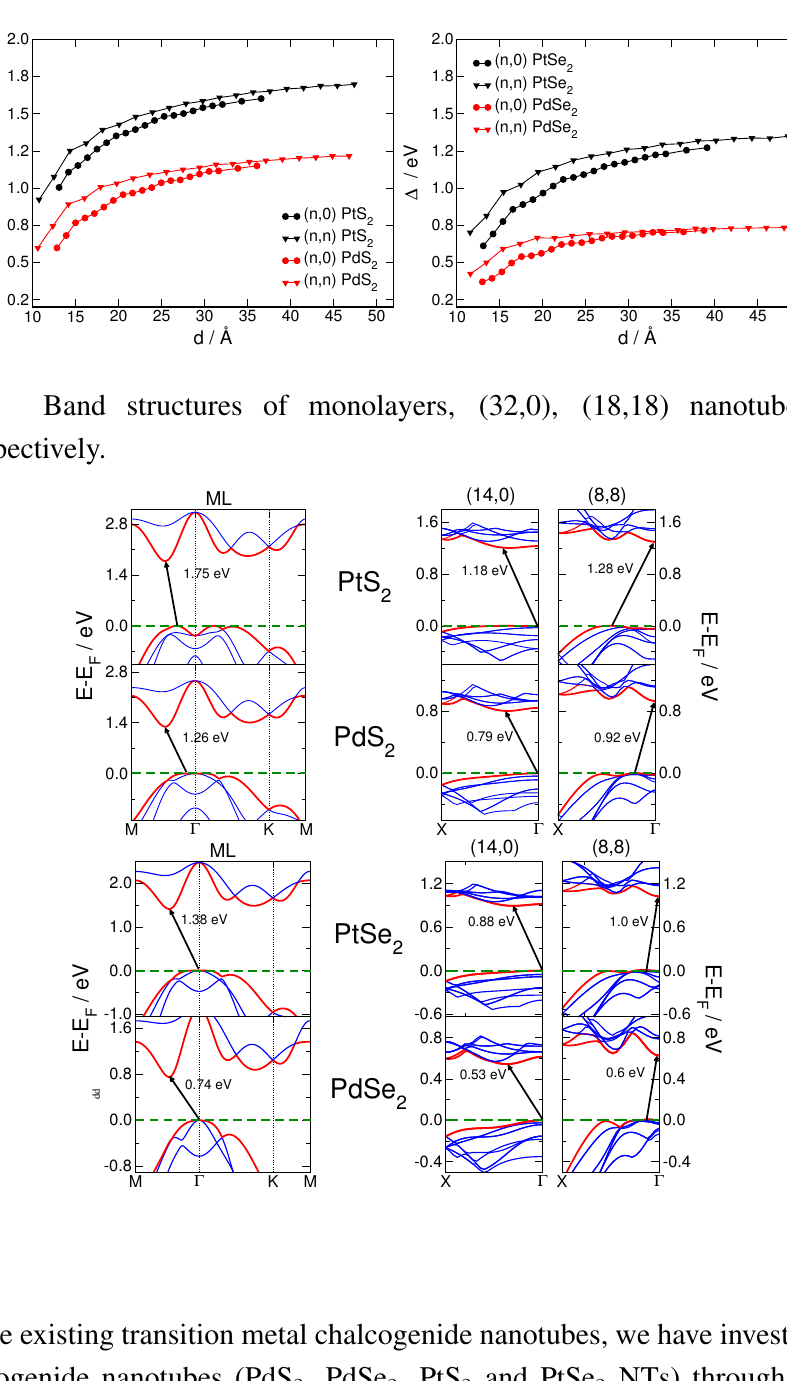
Figure 4. Band gap vs. diameter of MX